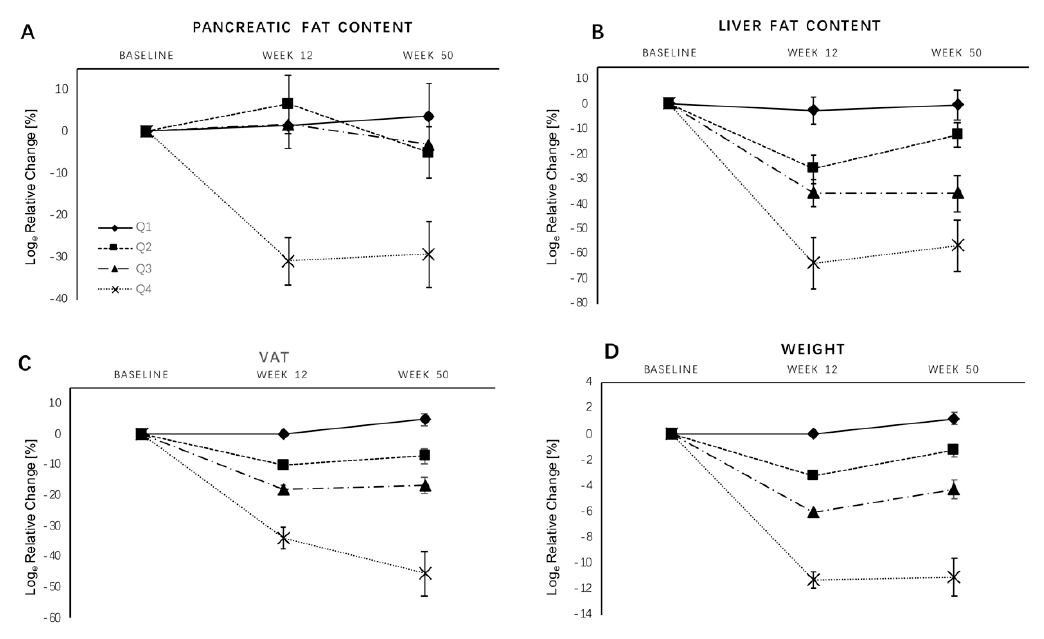
Figure 2. Relative changes in pancreatic fat content, liver fat content, VAT, and weight by weight-loss quartiles. ( A ) Pancreatic fat content; ( B ) liver fat content; ( C ) VAT, visceral adipose tissue; ( D ) weight. Data are shown as mean ± SEM for Log e relative change with baseline values as the reference.